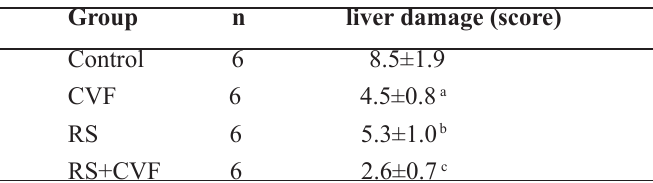
TABLE 3 - Score of liver damage of rats receiving liver xenotransplantation and subsequent different treatments ( x ± S